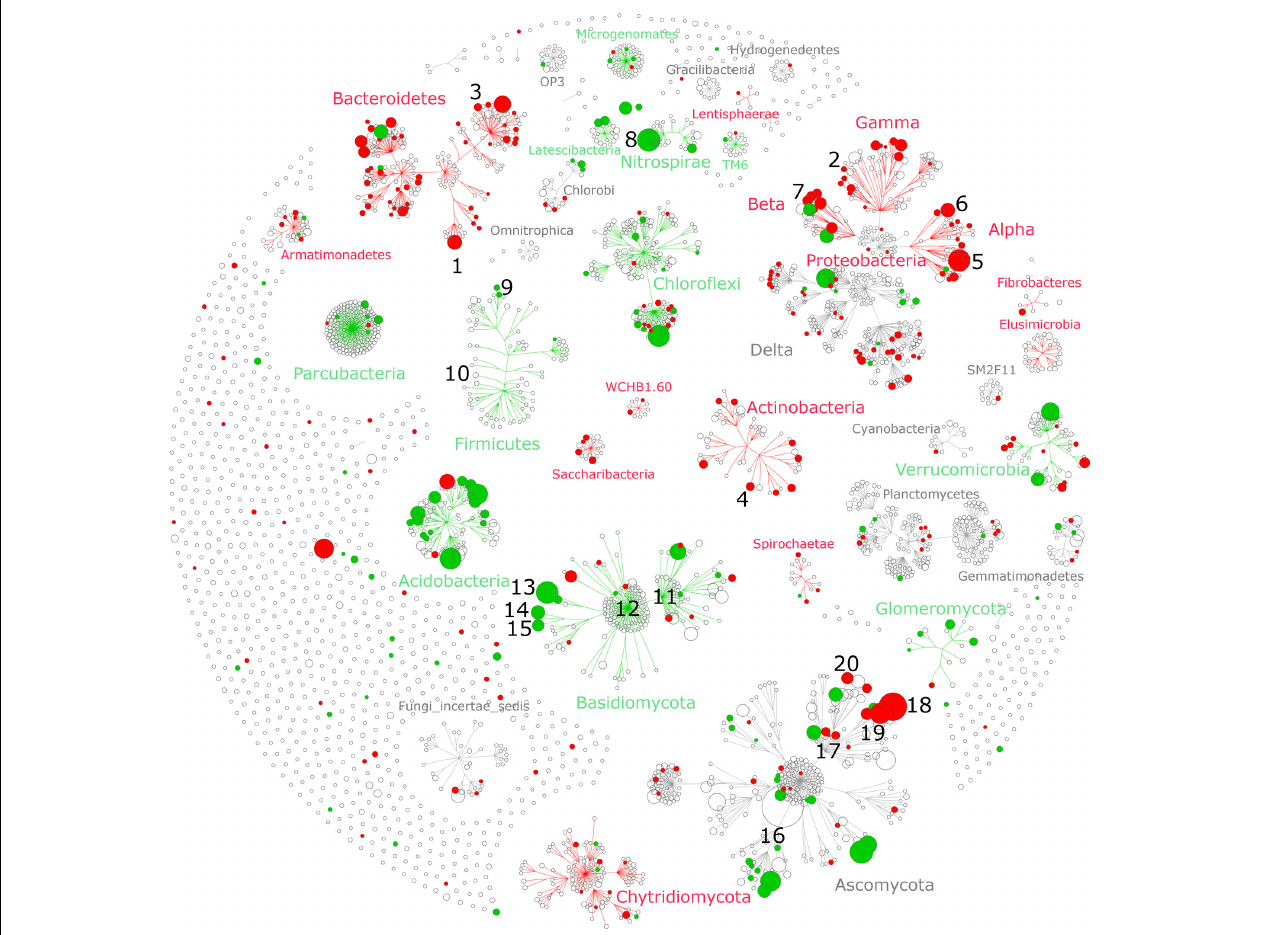
FIGURE 4 | Taxonomic networks showing the distribution of bacterial and fungal OTUs across the taxonomic hierarchy. Nodes correspond to OTUs and node size corresponds to their relative abundance (square root) in the dataset. Edges (lines connecting the nodes) represent the taxonomic path from phylum to OTU level, whereas OTUs are placed at the level of the lowest possible assignment. The response of individual OTUs to tillage was mapped onto the taxonomic network with green nodes corresponding to OTUs responding positively to reduced tillage (RT) and red nodes corresponding to OTUs responding positively to conventional tillage (CT). Only significant nodes were color-coded ( q < 0.05). The numbers (1–20) correspond to the most salient microbial groups showing a response to tillage and these are discussed in the section “Potential Interactions between Microbial Taxa and Their Environment” of the main